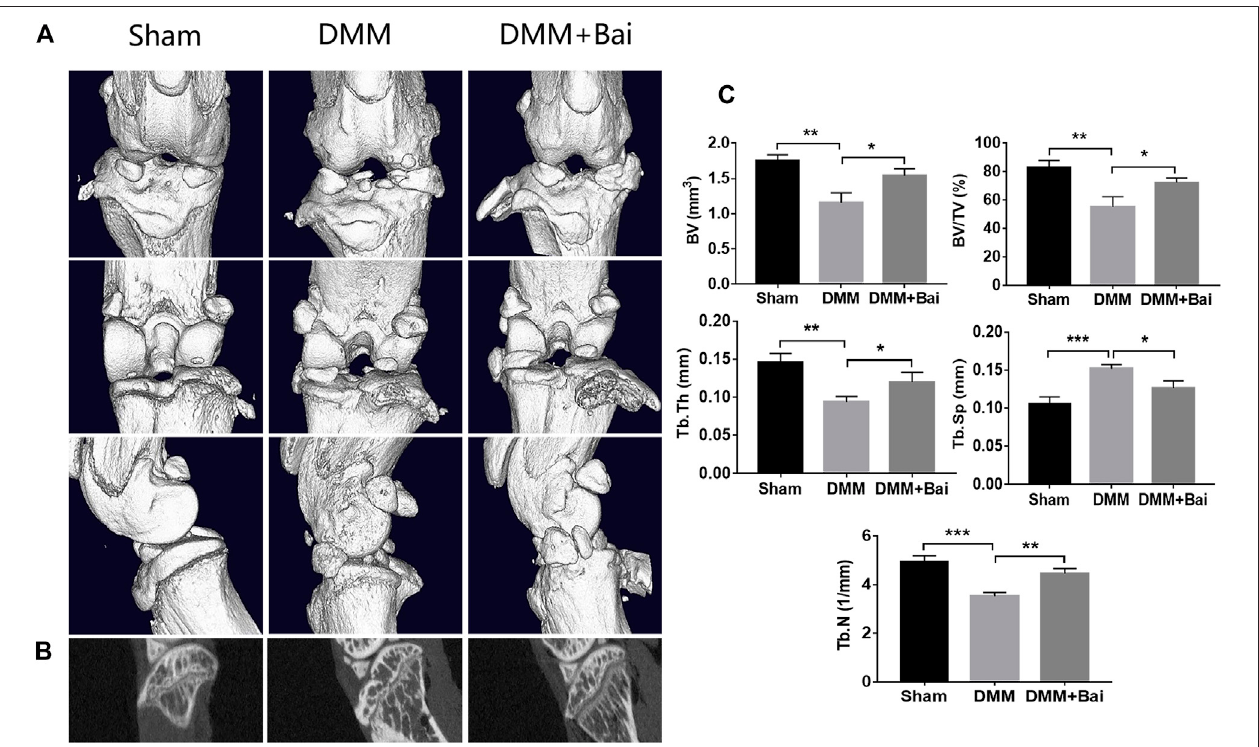
FIGURE 4 | Bai ameliorates subchondral bone resorption. (A) Three-dimensional micro-CT images of frontal, posterior and lateral views of the knee joints in each group. (B) Sagittalviewsofmedialcompartmentsubchondralbone. (C) QuantitativeanalysisofBV,BV/TV,Tb.Sp,Tb.Th,andTb.N.Dataareshownasthemean ±